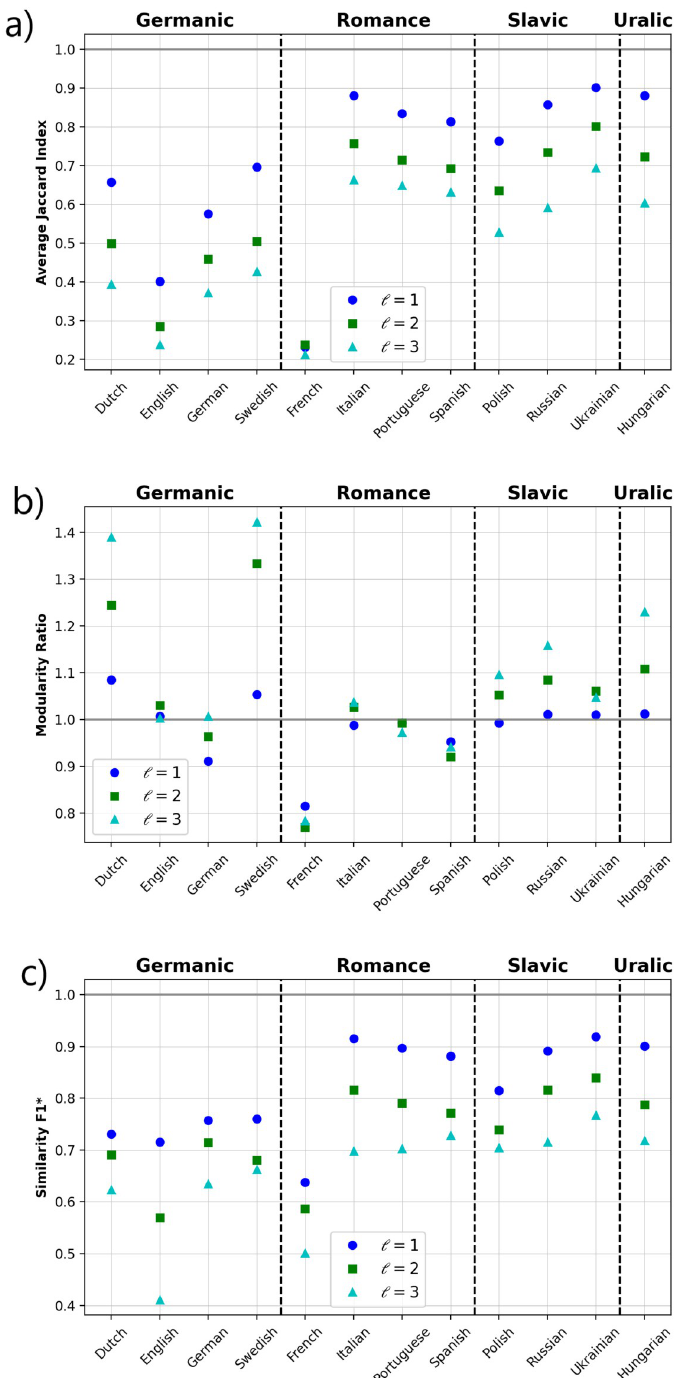
Fig 6. Average Jaccard index ( J ), modularity ratio and similarity F 1 � . (a) Jacccad’s index which indicate the extent of link overlap across layers. (b) Modularity ratio between layers. The value of the phonological layer divided by the value of the orthographic layer is shown. (c) Score F 1 � to evaluate the similarity between communities associated to a given modularity.